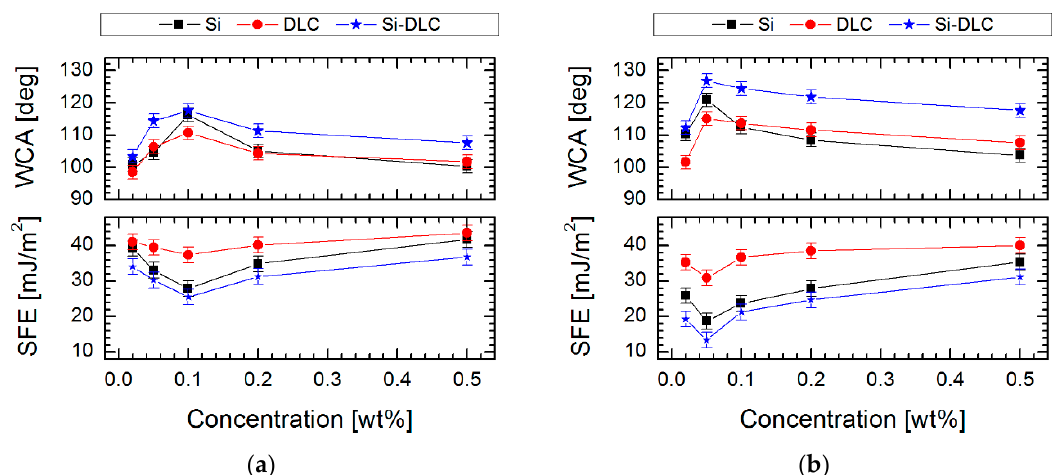
Figure 2. T Water contact angle (WCA) and surface free energy (SFE) of self-assembled monolayers (SAMs) created on three surfaces with different contents of silicon as function a concentration for ( a ) FPTS and ( b ) FDTS.